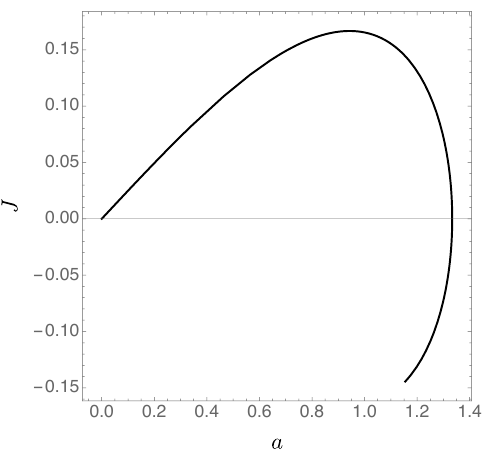
Figure 2 . J as a function of a , with a = a max = 4 = 3 corresponding to a change of sign in J